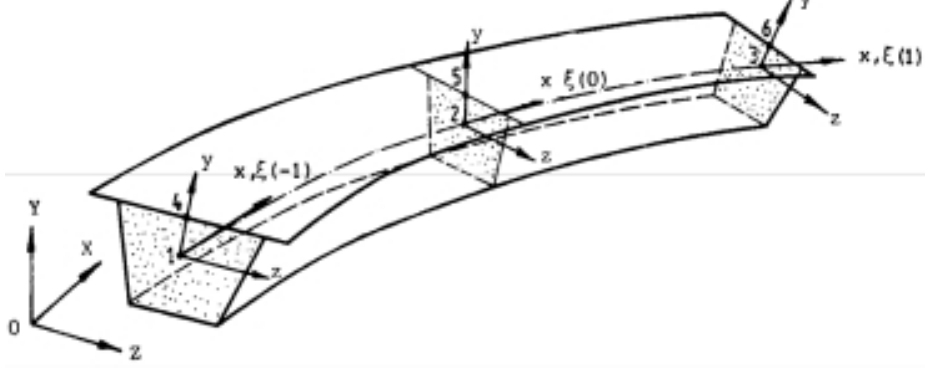
Fig. 2. Curved thin-walled box beam element with three